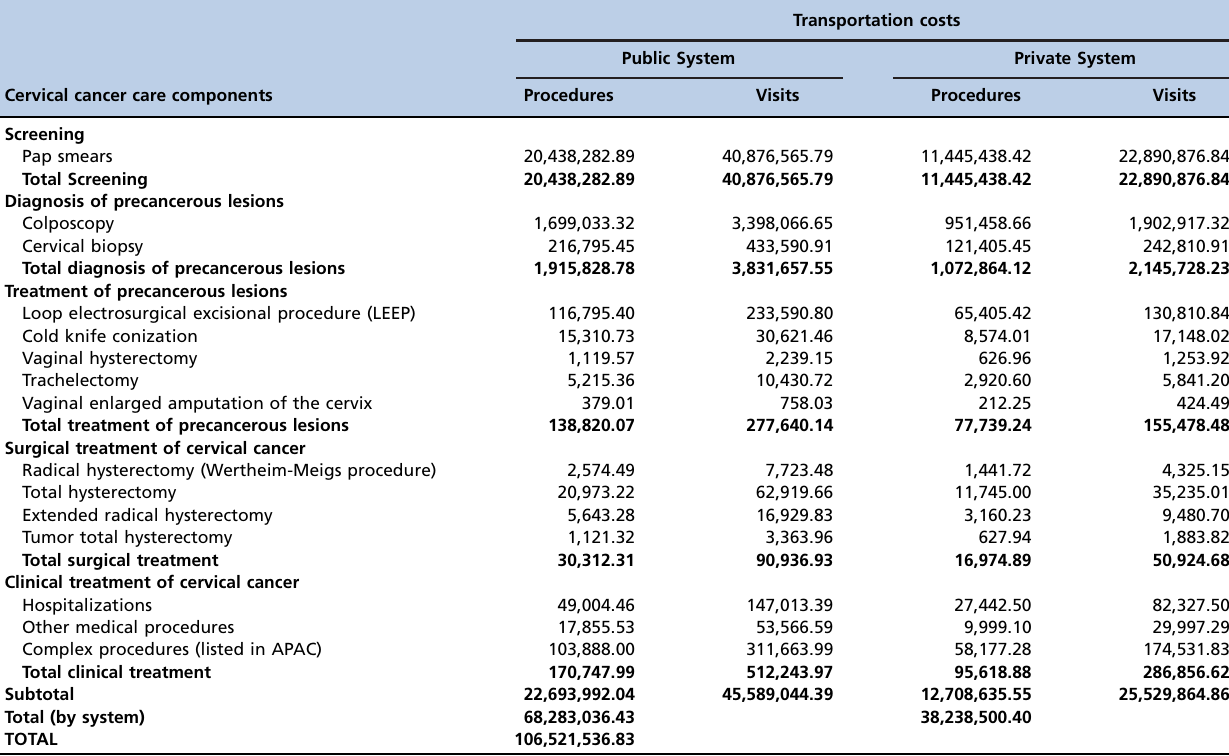
Table 2 - Estimates of non-medical direct costs (transportation) associated with the screening, diagnosis and treatment of precancerous lesions and the diagnosis and treatment of cervical cancer in the public and private health systems in Brazil, in 2006 United States dollars.